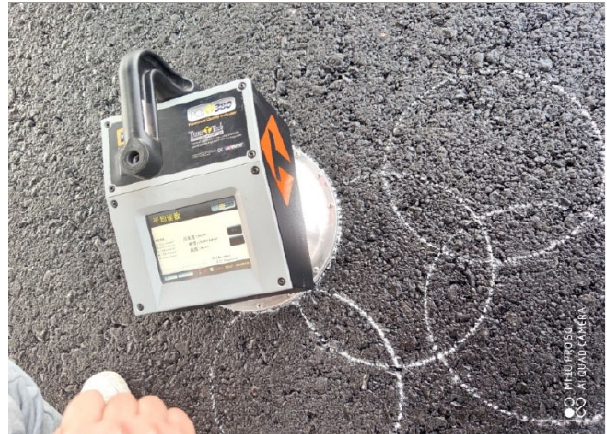
Figure 3. Density measurement using PQI at the calibration point.